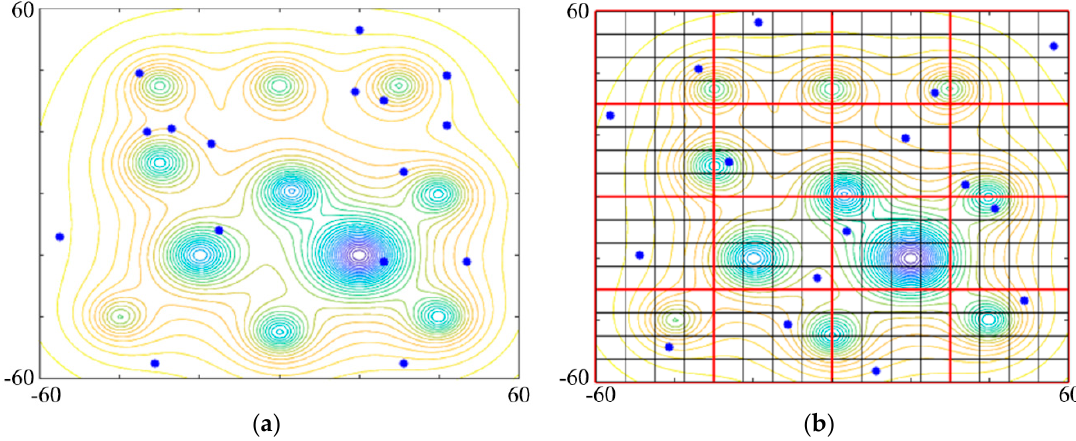
Figure 3. Example of sampling: ( a ) Random sampling; ( b ) Multi-Jittered sampling.